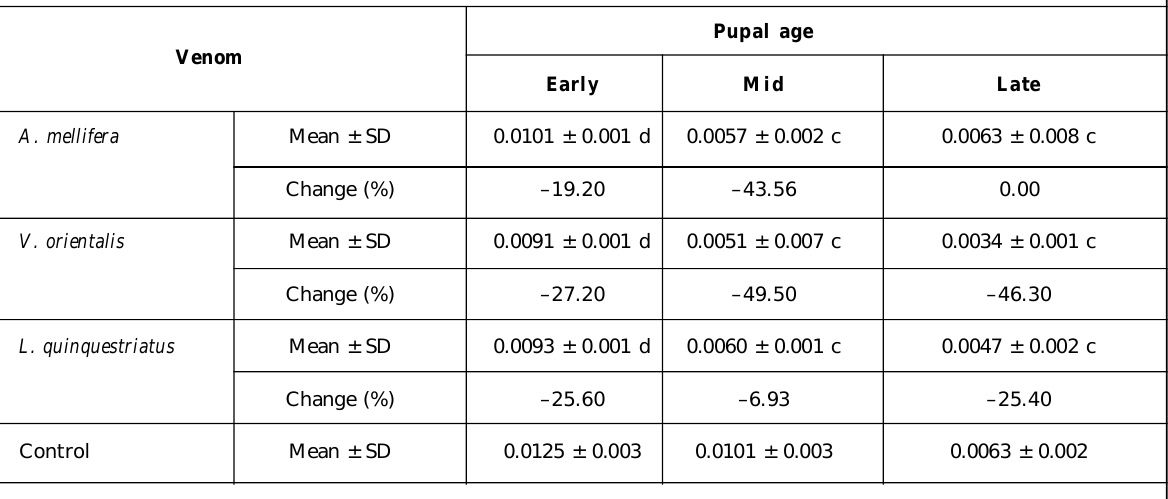
Table 6: Influenced total carbohydrate content (mg/g) in the pupal tissues after treatment of the 3 rd instar larvae of G. mellonella with LC values of certain arthropod 50